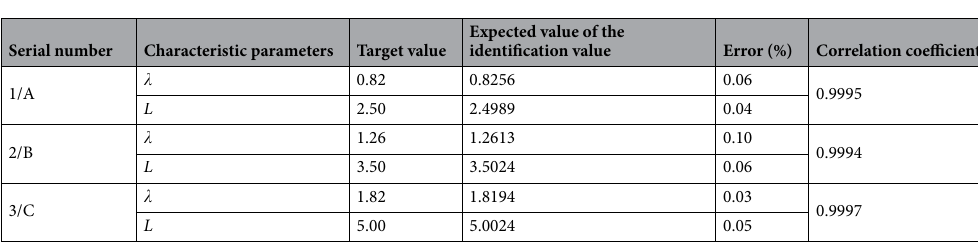
Table 3. Driver characteristics parameters identification results. 1 The serial number 1/A indicates the first group of feature target values, group A feature recognition expectation values,